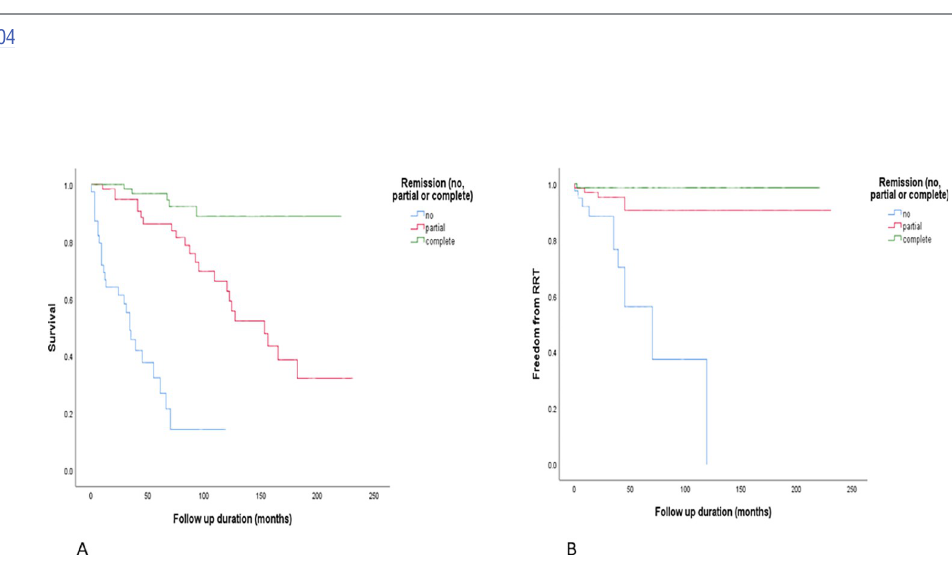
Fig 3. Overall survival (A) and freedom from RRT (B) in patients with no remission, partial remission, and complete remission. P-values < 0.001 and < 0.001 respectively